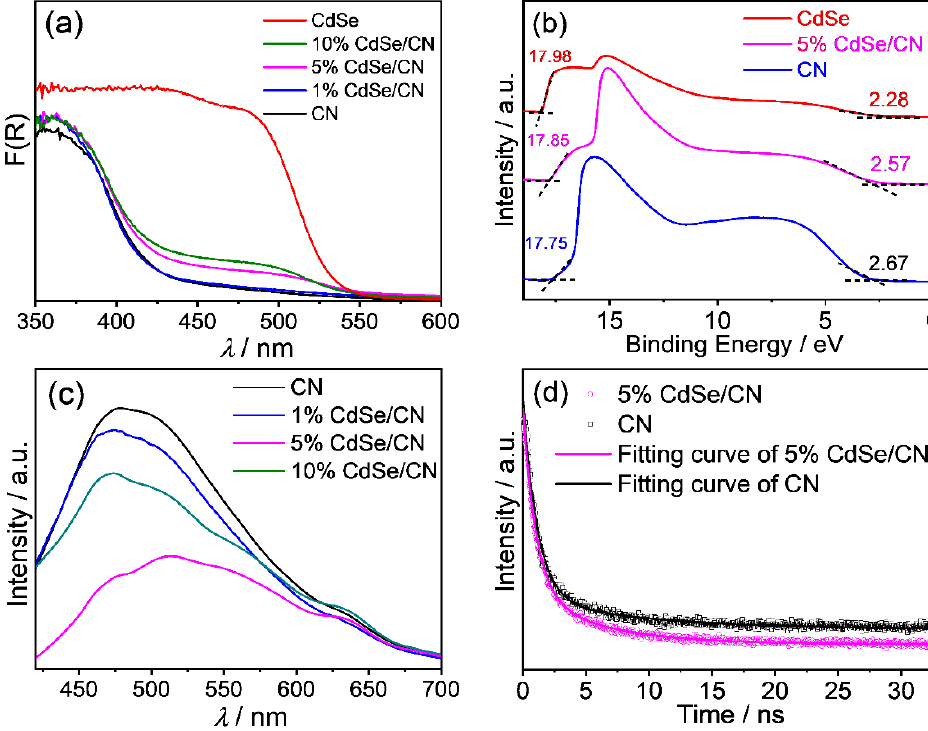
Figure 5. Optical properties of CdSe/CN: ( a ) UV–vis DRS spectra; ( b ) UPS valence band (VB) spectra of CN, 5% CdSe/CN, and CdSe; ( c ) steady-state photoluminescence spectra; and ( d ) time-resolved photoluminescence spectra of CdSe/CN composites at room temperature.